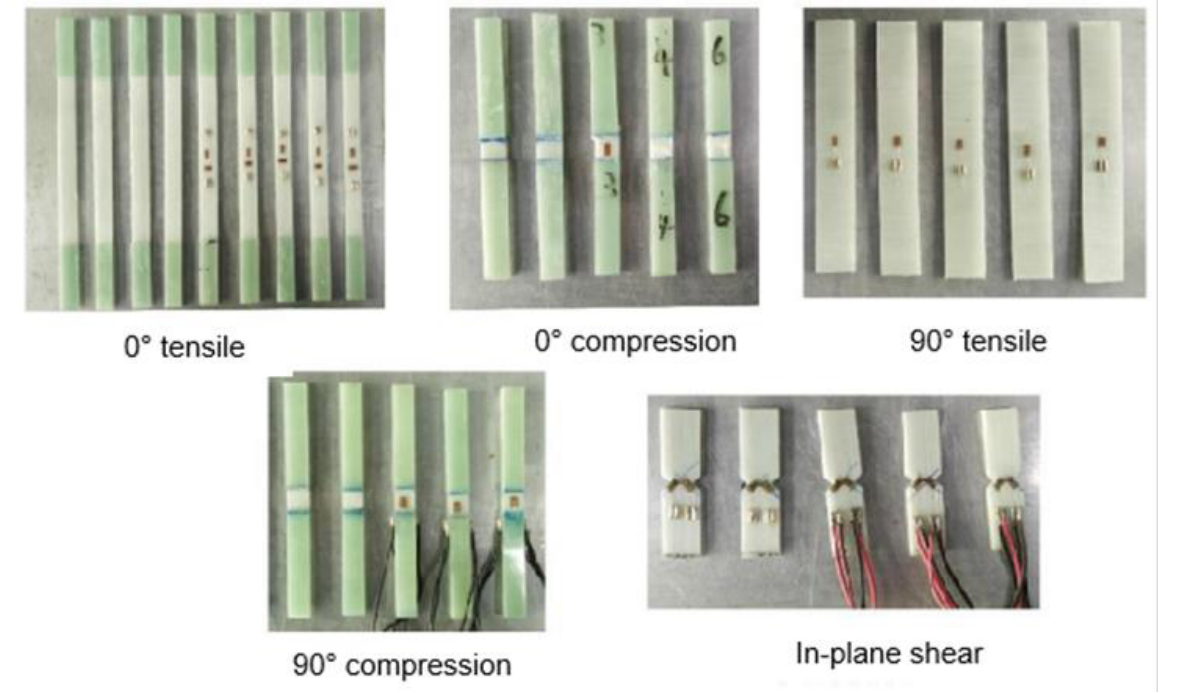
Figure 4. Different kinds of mechanical test specimens. Figure 4. different kinds of mechanical test specimens.